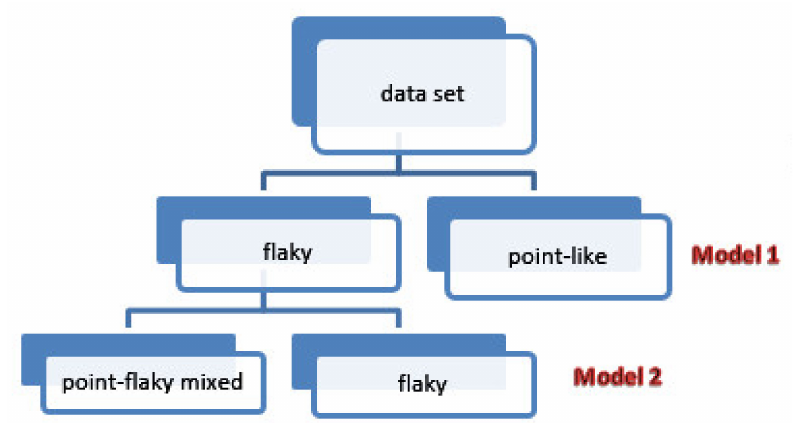
Figure 7. SVM models for general pattern